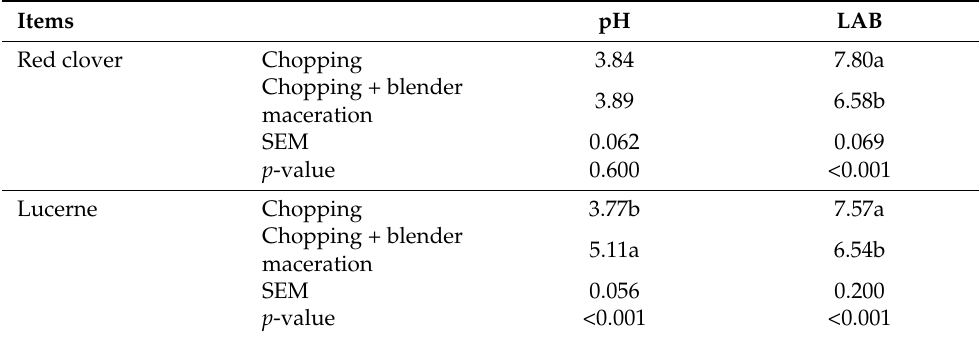
Table 1. pH and lactic acid bacteria (LAB, log CFU/mL FW) count of pre-fermented juice made from chopped, or blender macerated red clover or lucerne (n = 3).